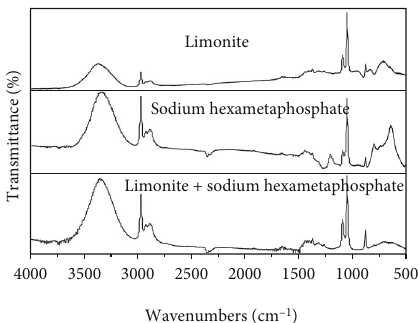
Figure 15: FTIR spectra of limonite and sodium silicate.